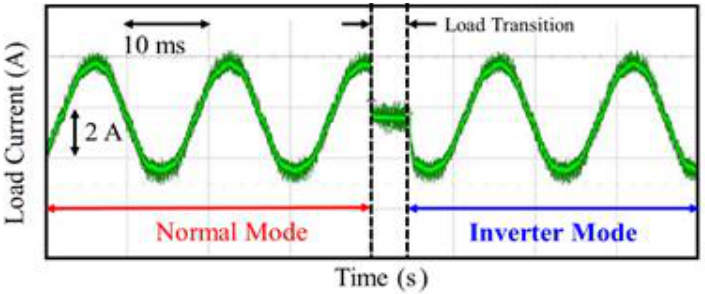
Figure 26. Experimental waveform of load current ( I Load ) using proposed single-phase offline UPS system during the inverter operating mode.